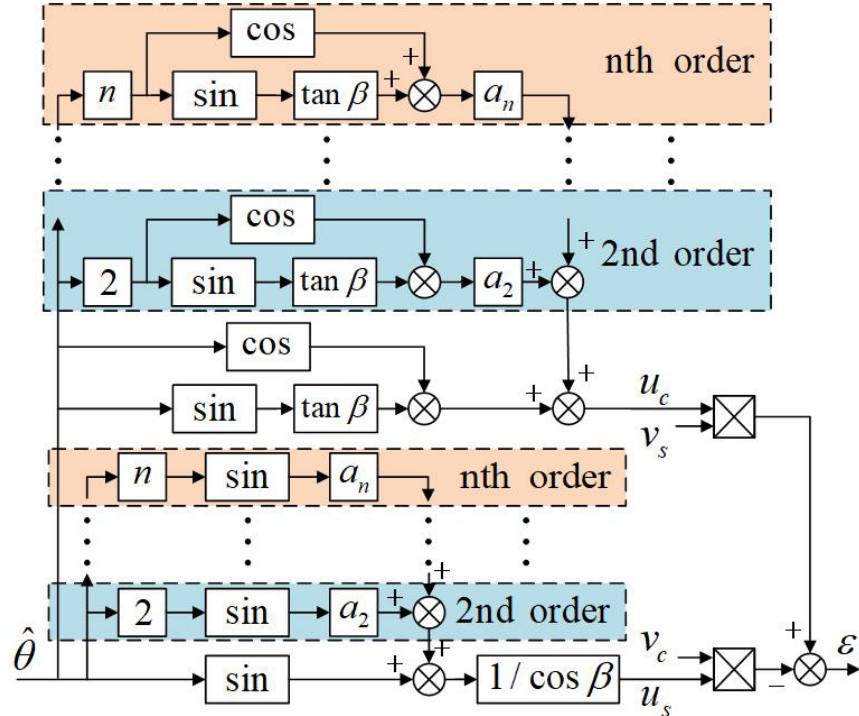
Figure 3. Schematic of proposed SQEH-PD.